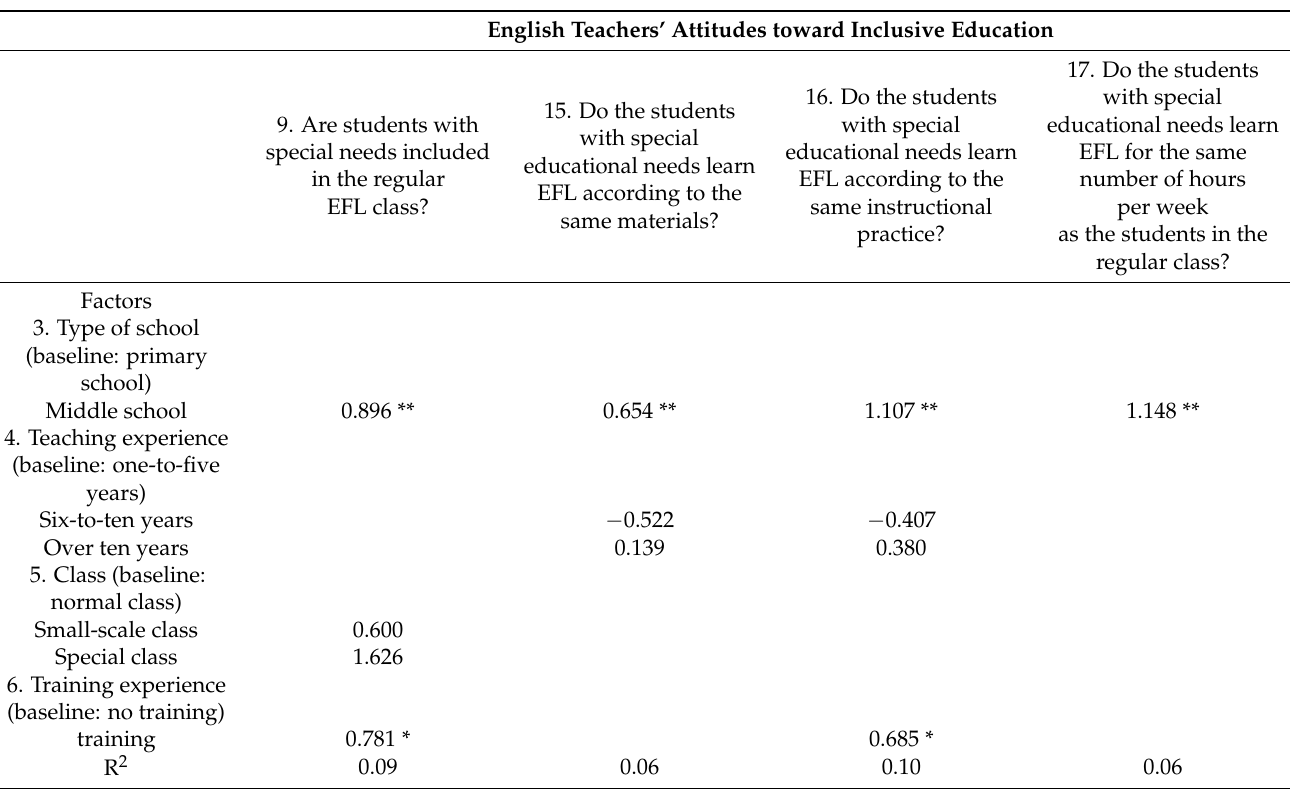
Table 5. Binary choice model to investigate the effects of teachers’ individual factors on their attitudes toward inclusive